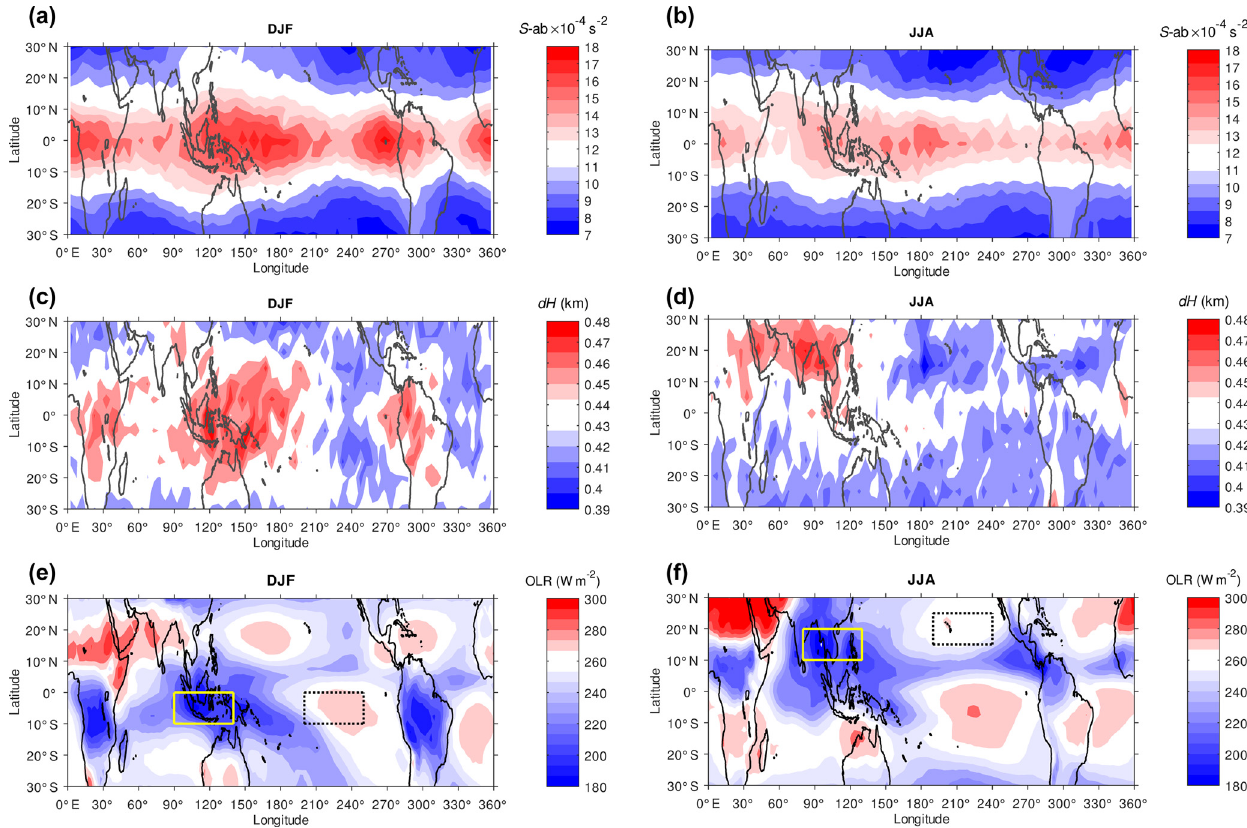
Figure 6. Horizontal distribution of the mean S -ab (a, b) , d H (c, d) , and OLR (e, f) during Northern Hemisphere winter (DJF) and summer (JJA). Solid yellow and dotted black boxes in the bottom row indicate the sample “convective” and “nonconvective” regions, respectively.